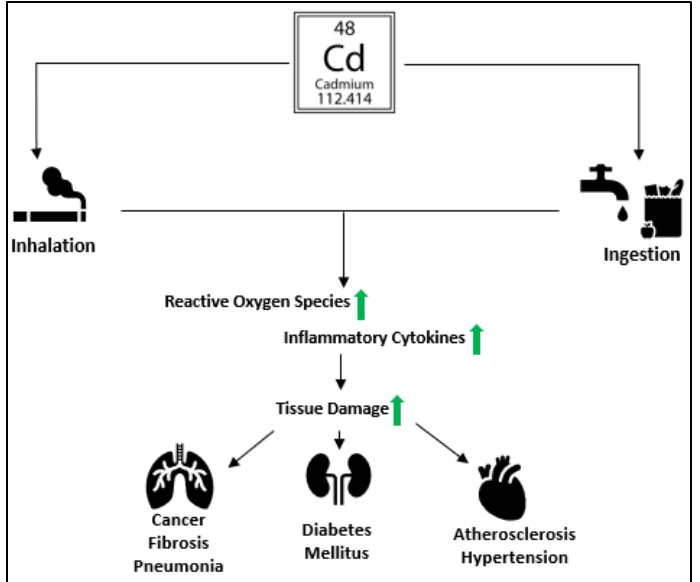
Figure 1. An illustration shows the effects of cadmium toxicity. Cadmium enters the human body from contaminated air, food, water, and tobacco smoking. It causes oxidative stress by increasing the production of ROS. Cd exposure results in the release of pro-inflammatory cytokines such as Interleukin-1 (IL-1), Interleukin-6 (IL-6), Interleukim-8 (IL-8), and Tumor necrosis factor-alpha (TNFα), leading to multi-organ tissue damage causing pneumonia, lung fibrosis, hypertension, diabetes mellitus, atherosclerosis, and cancer.